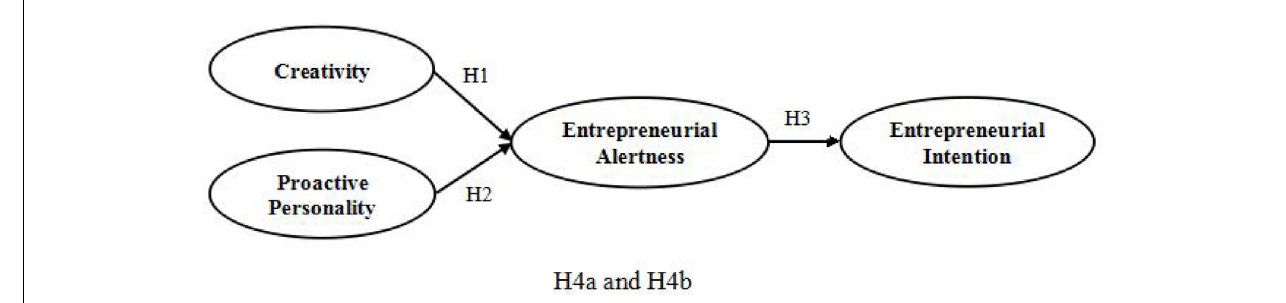
FIGURE 1 | The proposed structural relationships between creativity, proactive personality, entrepreneurial alertness, and entrepreneurial intention.